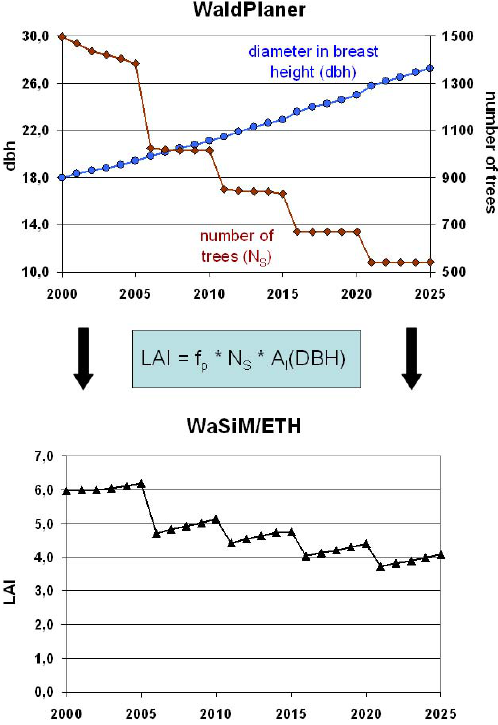
Fig. 3. Calculation of leaf area index for a Norway spruce stand from the LOEWE